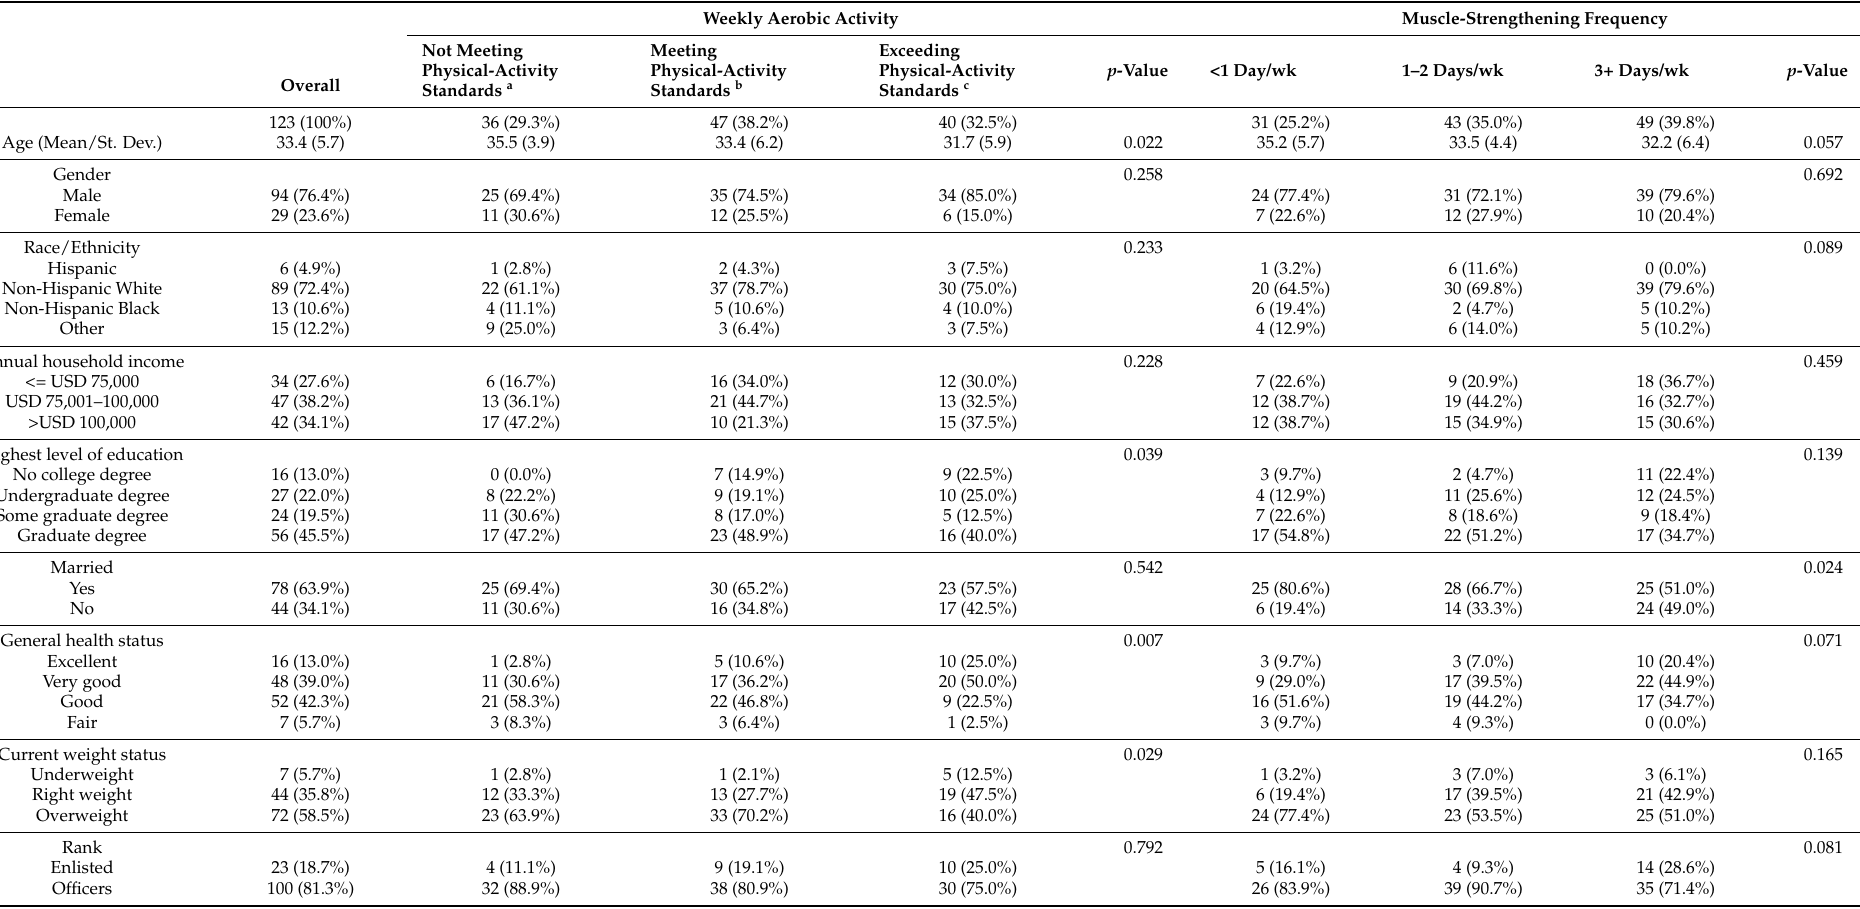
Table 2. Participant demographic characteristics by physical activity